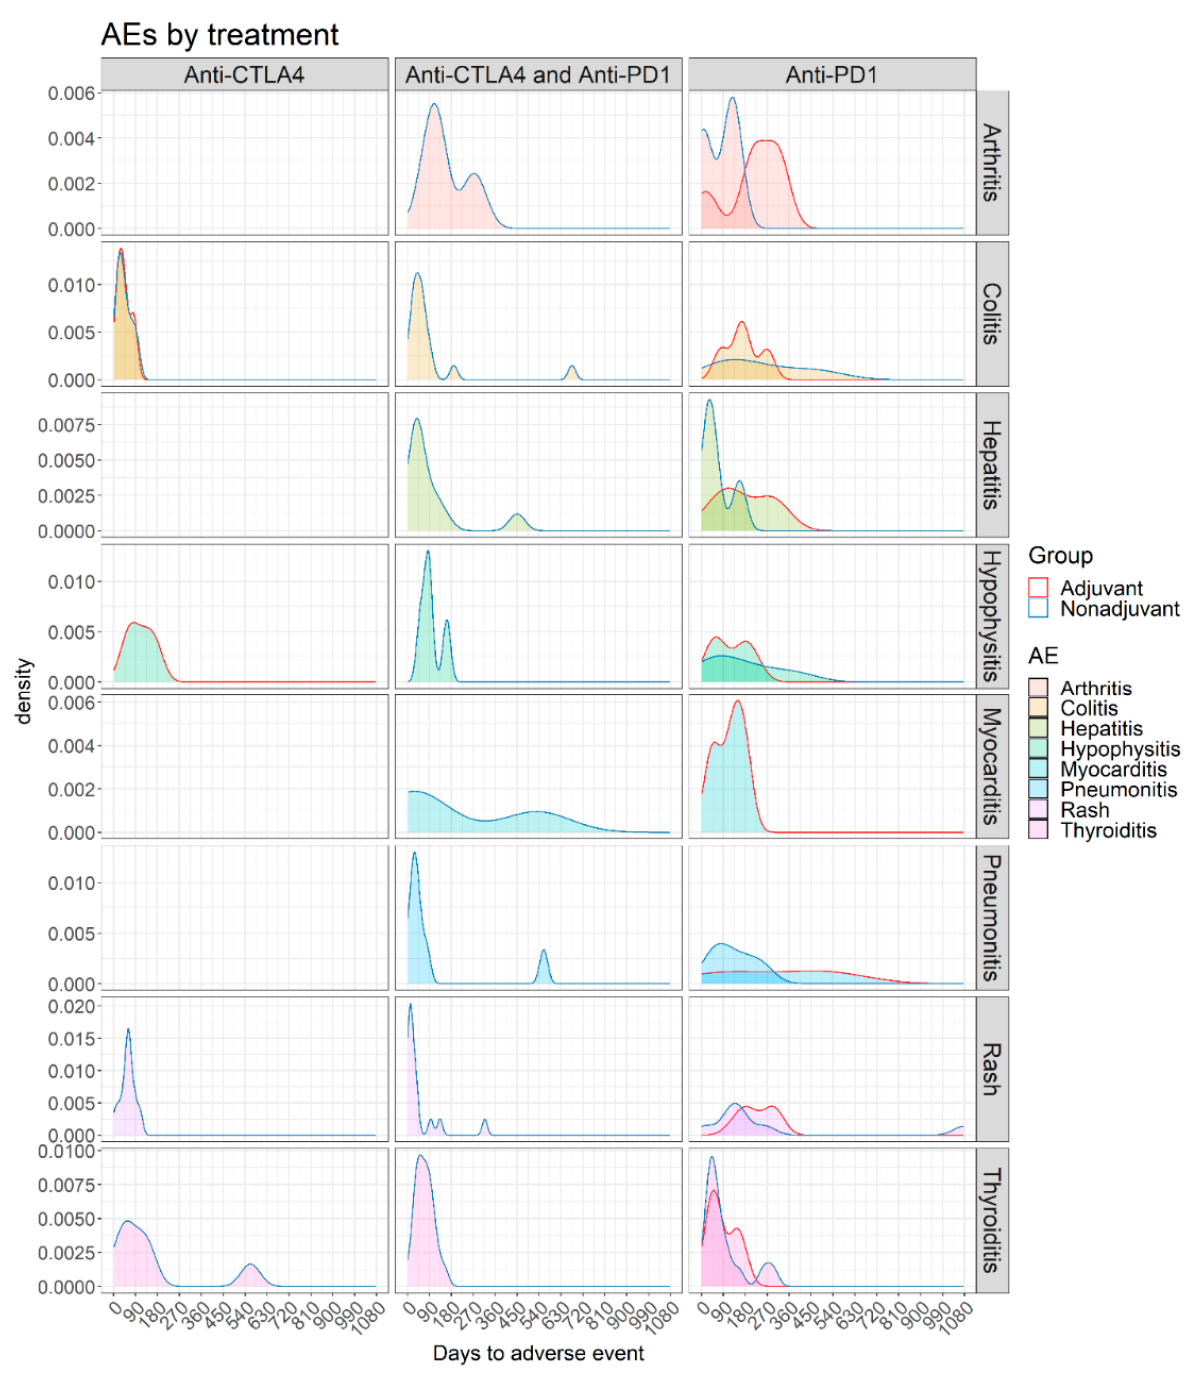
Figure 2. Density plots representing the time of appearance of arthritis, colitis, hepatitis, hypophysitis, myocarditis, pneumonitis, rash and thyroiditis in adjuvant and non-adjuvant patients treated with anti-CTLA4, anti-PD1, and anti- CTLA4 with